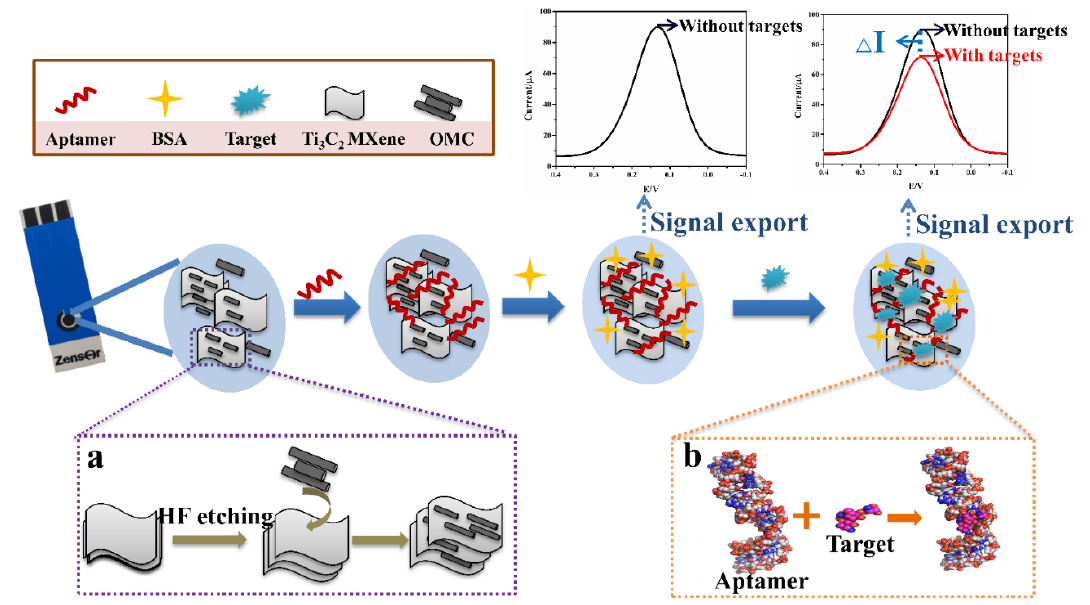
Scheme 1. Schematic illustration of the aptasensor fabrication process: ( a ) Forming process of